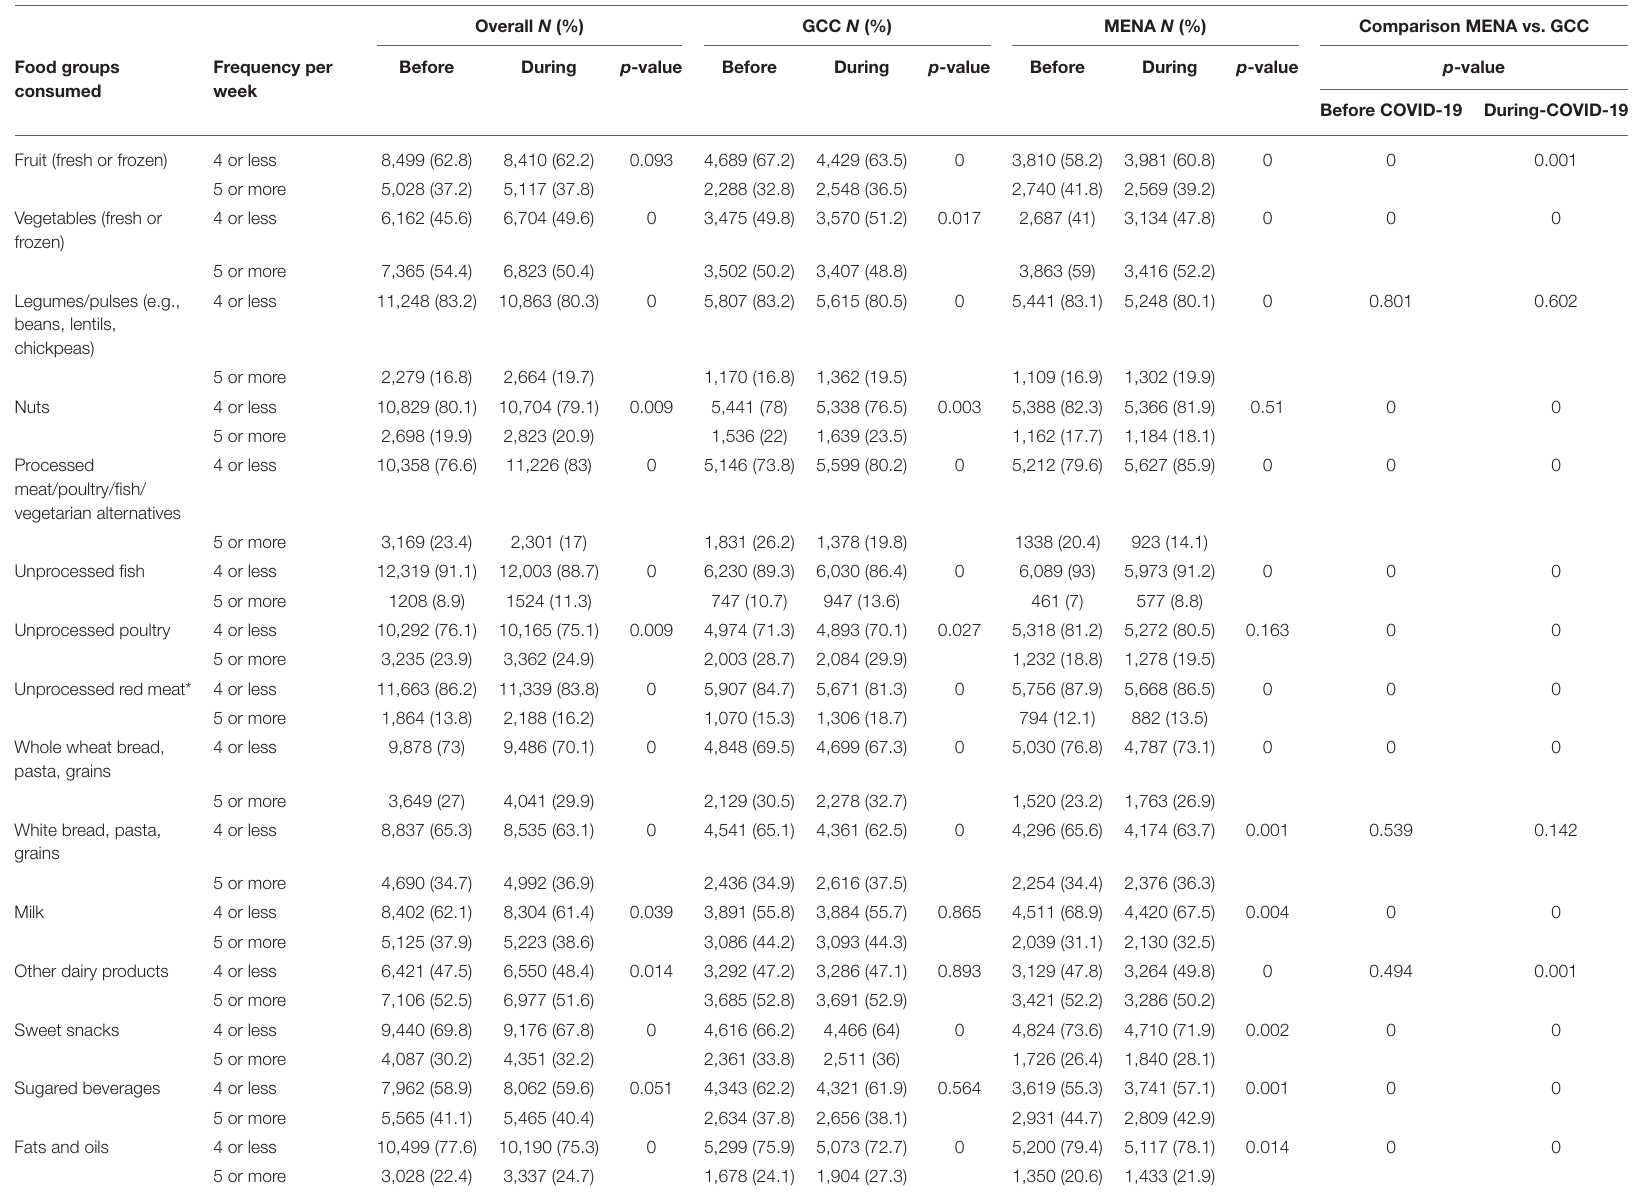
TABLE 2 | Food groups consumption among countries in the GCC and MENA regions, before and during COVID-19 pandemic. Overall N (%) MENA N (%) Comparison MENA vs.